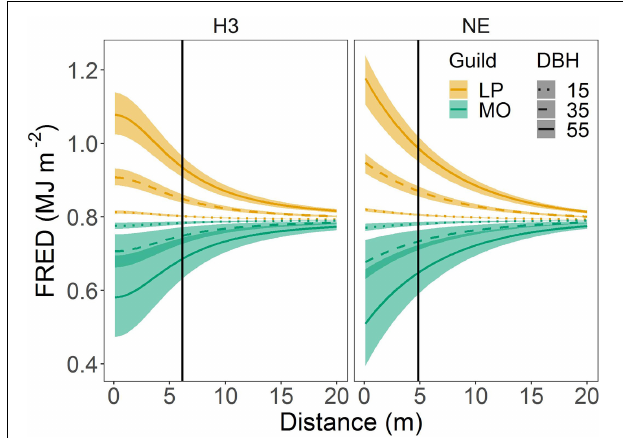
FIGURE 1 | Neighborhood models [Holling type III (left panel) and negative exponential (right panel) ] illustrating effect of distance from tree (two guilds and three DBH sizes) on predicted FRED from prescribed fires in longleaf pine woodlands in southwest Georgia, United States (shaded area indicates 2 AIC unit support interval). Vertical lines represent the distance at which the effect of a tree was half its maximum. Guild abbreviations are LP, longleaf pine; MO, mesic oaks.